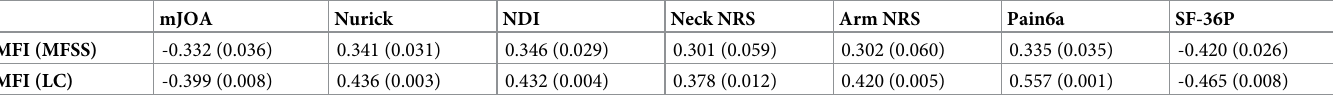
Table 3. Association between muscle fat infiltration, clinical and HRQOL scores. mJOA Nurick NDI Neck NRS Arm NRS Pain6a SF-36P MFI (MFSS) -0.332 (0.036) 0.341 (0.031) -0.420 (0.026) MFI (LC) -0.399 (0.008) 0.436 (0.003) 0.432 (0.004) 0.378 (0.012) 0.420 (0.005) 0.557 (0.001) -0.465 (0.008) MFI = Muscle Fat Infiltration, MFSS = multifidus and semispinalis cervicis, LC = longus colli and longus capitis, mJOA = modified Japanese Orthopedic Association, NDI = Neck Disability Index, NRS = Numerical Rating Scale, Pain6a = Pain Interference Scale, SF-36P = Health and well-being survey (physical component score). Spearman’s ρ (p-value) are